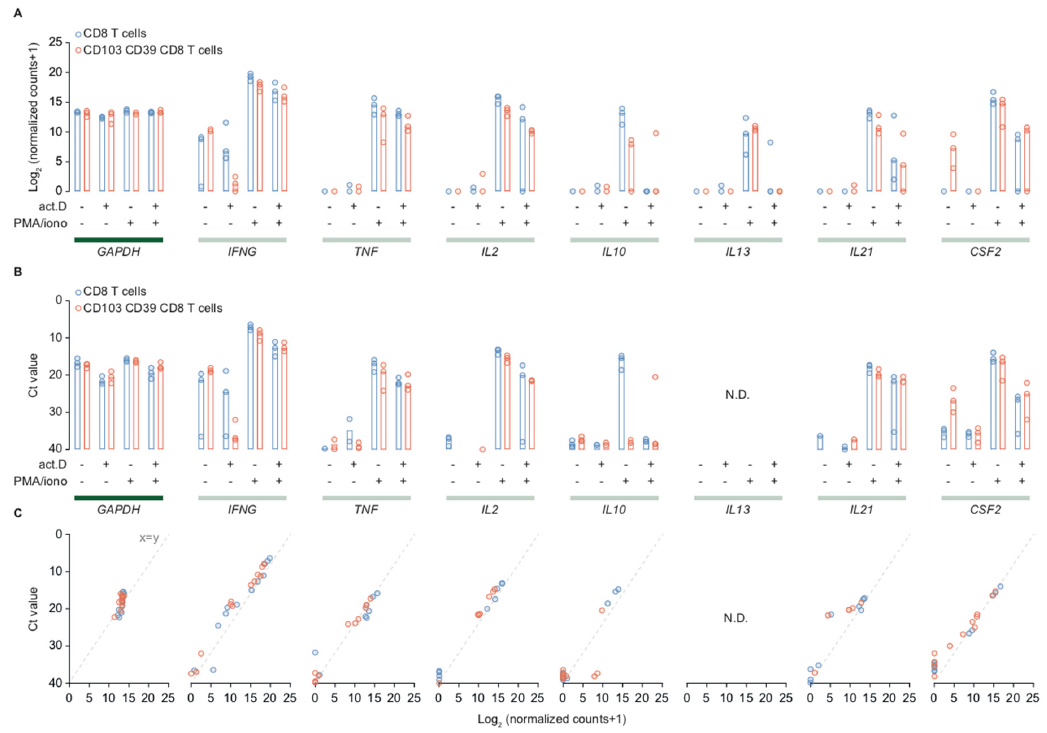
Figure 4. CD39 + CD103 + T RM and CD8 + TIL robustly express cytokine genes upon stimulation with PMA / ionomycin. ( A ) Overview of log2-normalized counts of CD39 + CD103 + T RM (red) and CD8 + TIL (blue). Expression is depicted per treatment condition for GAPDH (household gene) and a series of cytotoxic T cell cytokines. Bars depict the median. ( B ) Overview of Ct-values determined using qPCR of CD39 + CD103 + T RM (red) and CD8 + TIL (blue) for the same conditions as depicted in A. qPCR for IL13 was not determined (N.D.). Bars depict the median. ( C ) Correlation plots of Ct-values versus normalized counts of CD39 + CD103 + T RM (red) and CD8 + TIL (blue). The dashed line represents a reference correlation of 1 (x = y).